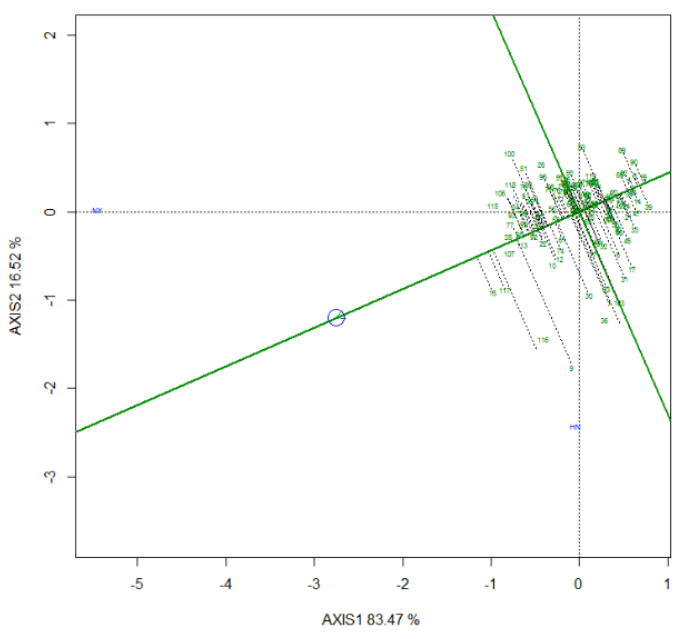
Figure 6. Ground diameter mean and stability.